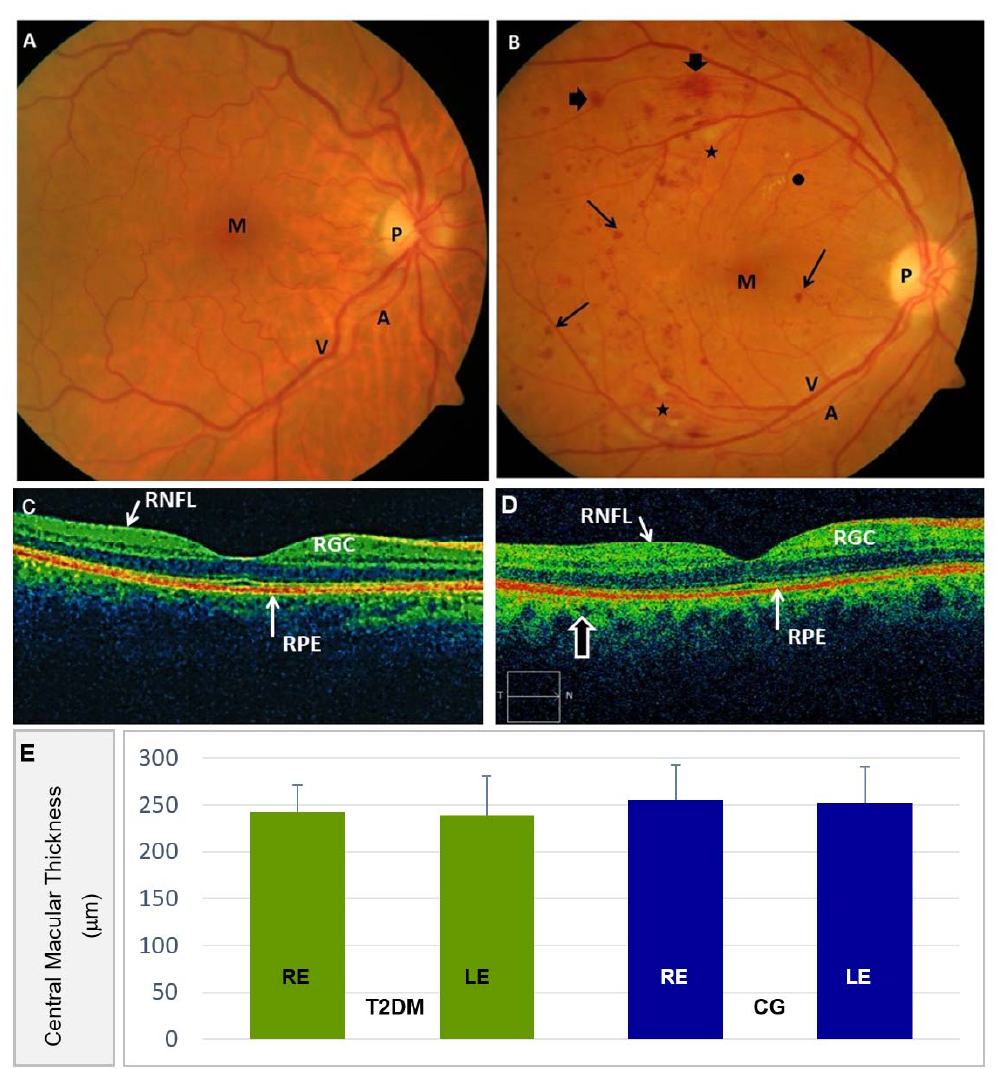
Figure 3. Ocular Fundus imaging. ( A ) Standard color fundus retinography showing 30° of the posterior eye pole (including the optic nerve head and the macula) of the RE from a participant of the CG (P: Optic nerve papilla; M: Macula; A: Retinal artery; V: Retinal vein). ( B ) Standard color fundus retinography showing 30° of the posterior eye pole of the RE displaying the clinical microvascular angiopathy manifestations of a T2DM patient with nonproliferative diabetic retinopathy (NPDR). Note the microaneurysms and abundant microhemorrhages (arrowthin), as well as macrohemorrhages (arrowhead). Scarce hard exudates ( ● ) and cotton ‐ wool spots ( * ) (being the latter grey ‐ white discolored plaques located in the retinal nerve fiber layer, corresponding to local ischemic areas) were detected. The same abbreviations reflected in A for the main retinal structures can be detected in this pathologic image. No macular alterations were detected in this NPDR retinography. ( C ) Spectral Domain Optical Coherence tomography (SD ‐ OCT) of a CG participant. Normal macular structural details of the same healthy participant as referred to in A. Among other retinal structures, the retinal nerve fiber layer (RNFL), retinal ganglion cell (RGC), and the retinal pigment epithelium (RPE)/Bruch’s membrane complex can be identified. ( D ) The microaneurysms and the hemorrhages (identified as hypo ‐ reflective lesions) were present in the SD ‐ OCT scans of the above diabetic patient, as referred in B. No macular changes and no neovascularization were detected in the NPDR images. ( E ) Central Macular Thickness in the right eye (RE) and left eye (LE) of the T2DM participants, as compared to the CG.